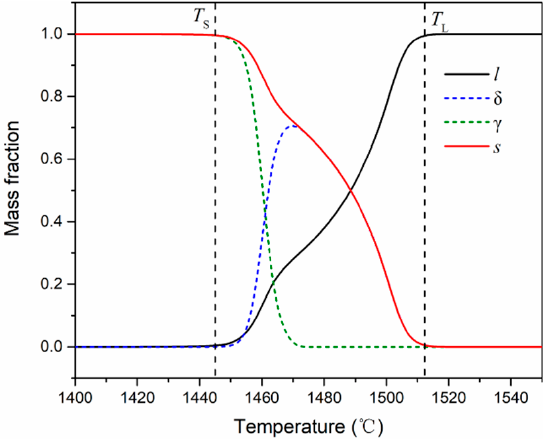
Figure 2. Phase fraction as a function of temperature for the C110 oil pipe steel.